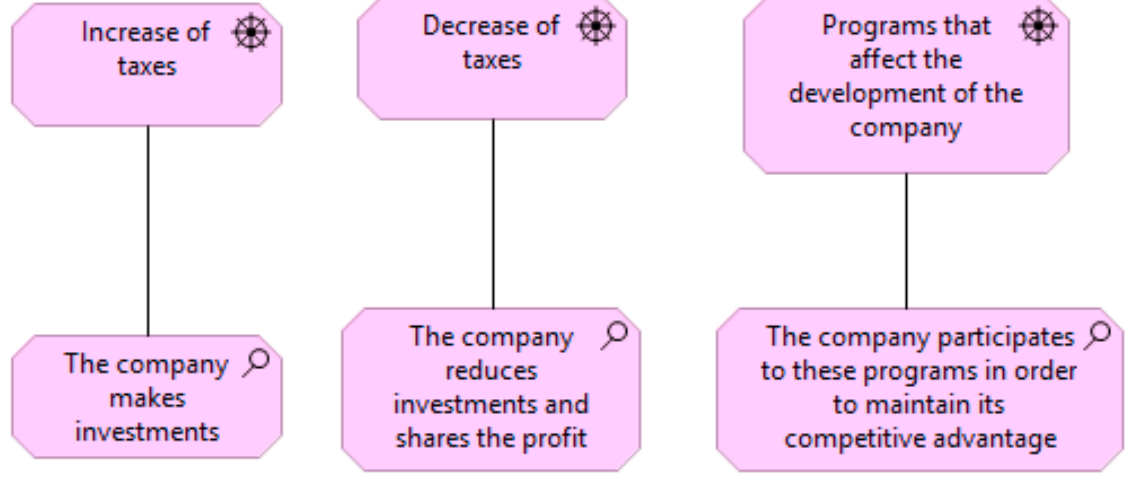
Figure 2. Analysis of external factors-economy.